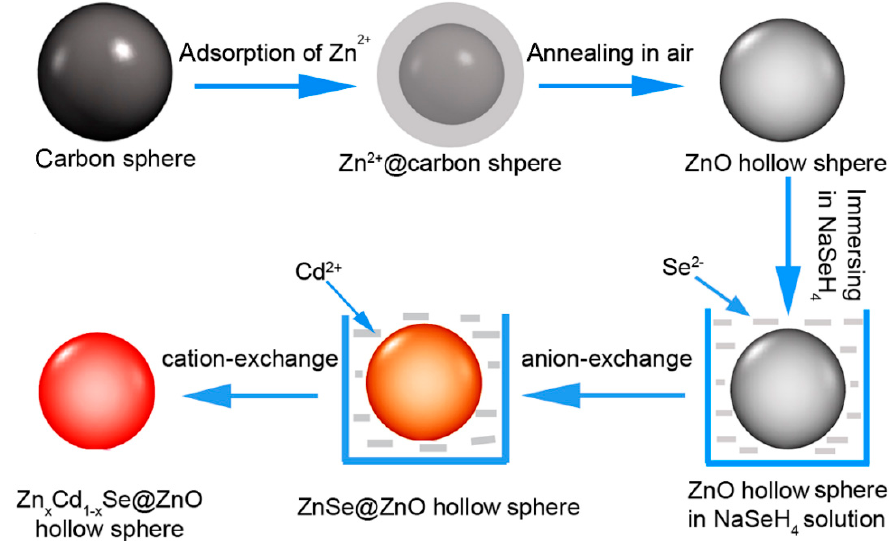
Figure 5. Illustration of the template approach to fabrication of ZnO HS and the ion-exchange process to the preparation of Zn x Cd 1-x Se@ZnO HS.